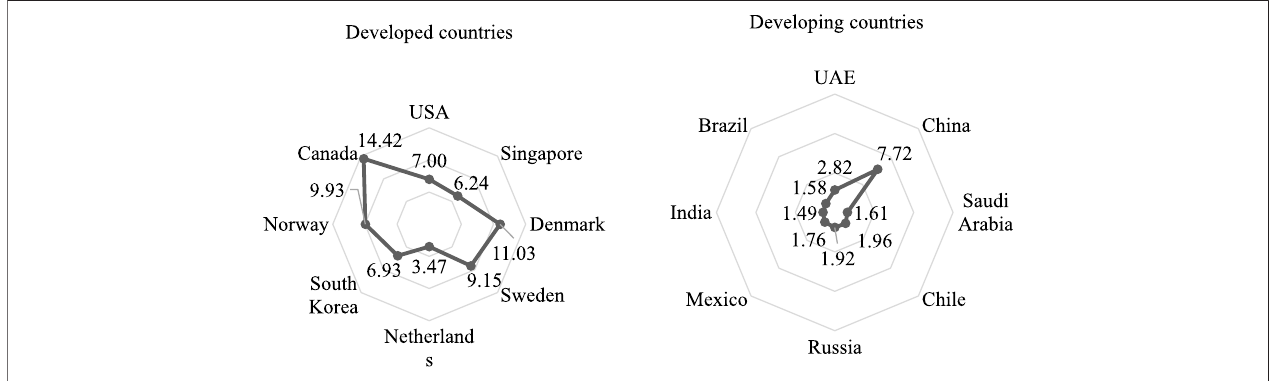
TABLE 1 | Energy ef fi ciency, environment pollution, and the ICTs factors that potentially in fl uence them in developed and developing countries in 2020. Category of Country Results in the sphere of countries energy ef fi ciency and